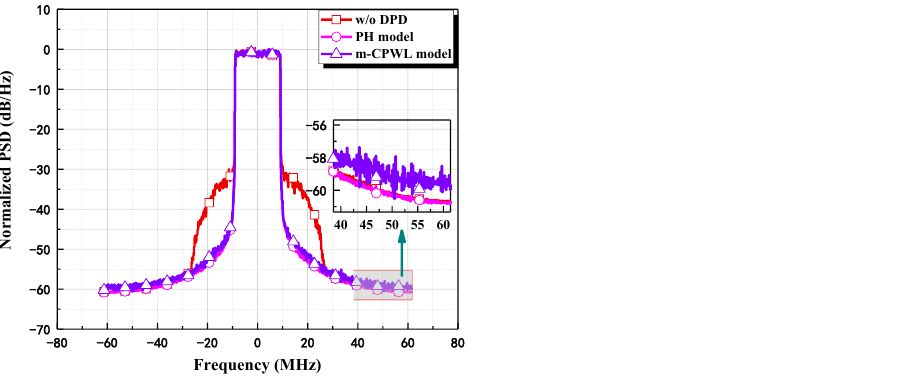
Figure 4. Normalized frequency power spectrum density (PSD) of proposed DPD models (simulation).